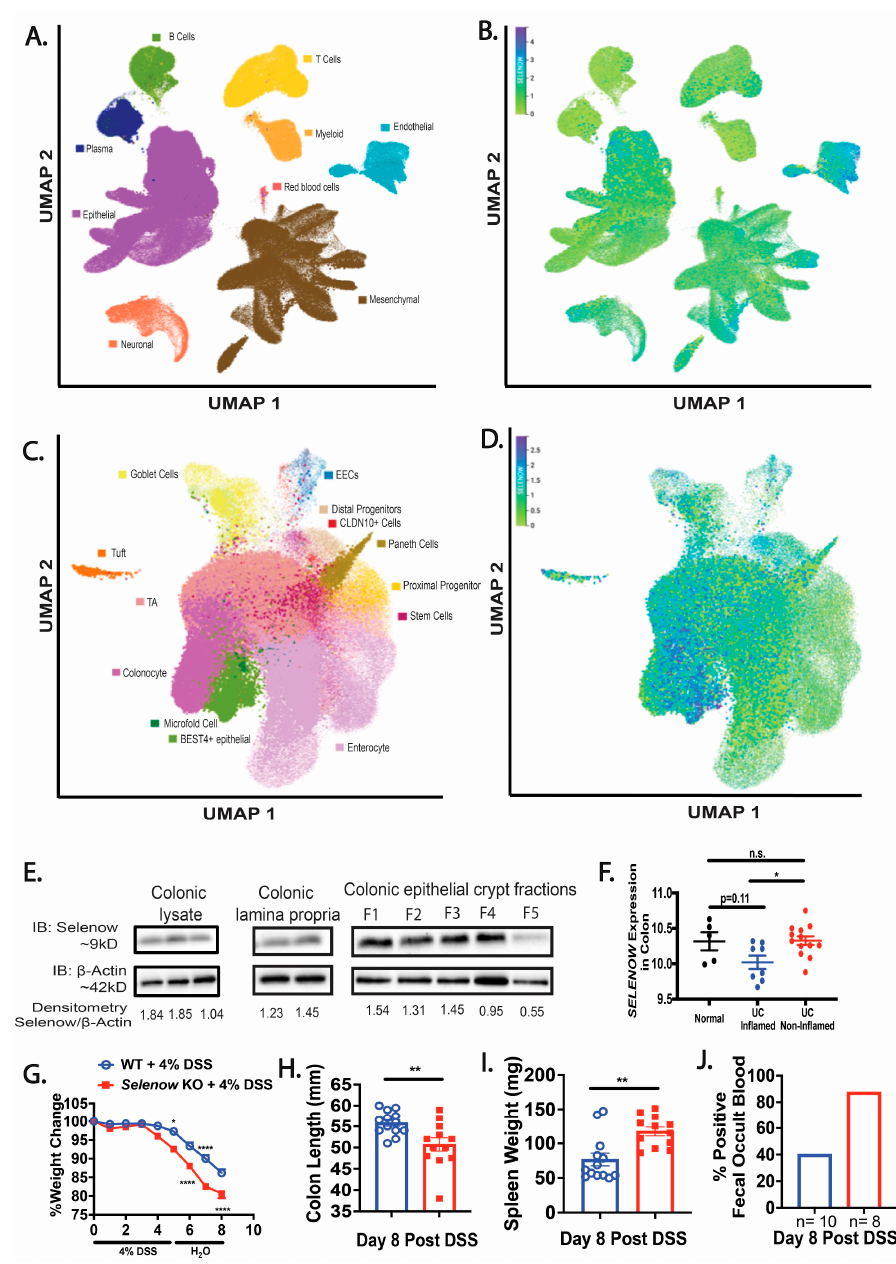
Figure 1. Critical role of Selenow in alleviating DSS-induced colitis. ( A ) and ( B ) SELENOW expression in the colonic and small intestinal cells from healthy human samples using the Gut Cell Atlas scRNA-seq data. ( C ) and ( D ) SELENOW expression in various cell types of healthy human colonic and small intestinal epithelium from the Gut Cell Atlas scRNA-seq data. ( E ) Expression of Selenow in colonic lysates, colonic lamina propria, and colonic epithelial crypts. ( F ) SELENOW expression in the colon of UC patients. ( G ) Percent weight change of WT and Selenow KO mice following administration of 4% DSS (WT = 17 mice; Selenow KO = 15). ( H ) Colon length of WT and Selenow KO mice at day 8 post DSS (WT = 13 mice; Selenow KO = 12). ( I ) Splenic weight of WT and Selenow KO mice at day 8 post DSS (WT = 13 mice; Selenow KO = 12). ( J ) Percentage of fecal occult blood positive WT